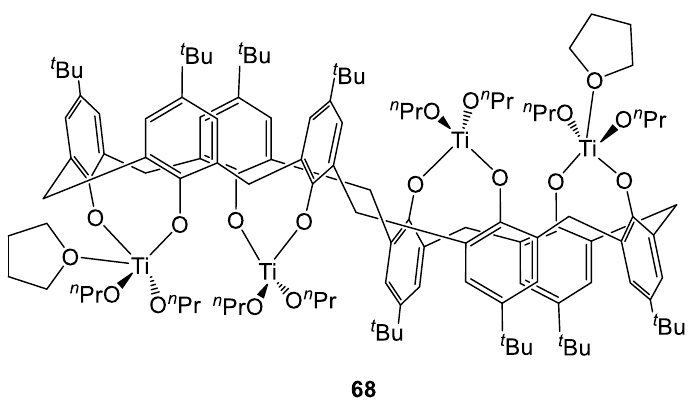
Catalysts 2020 , 10 , 210 Figure 19. Tetranuclear titanium complex 68 synthesized by McIntosh et al. [42].